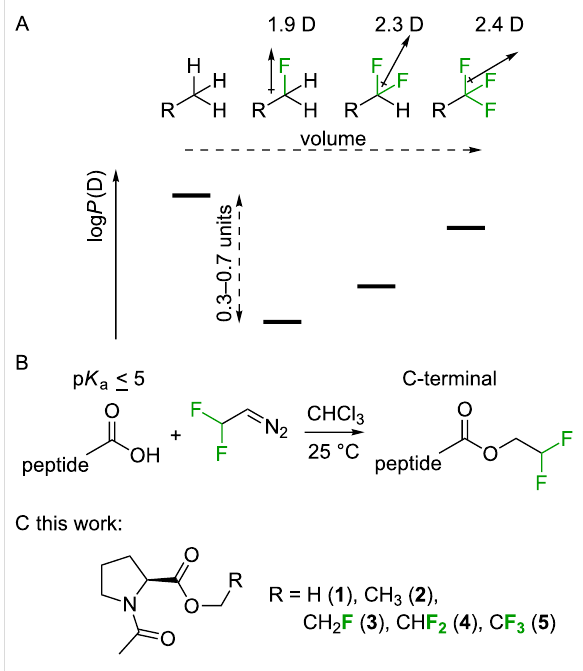
Figure 1: A. Dependence of the lipophilicity (log P ) on the number of fluorine atoms in a partially fluorinated terminal alkyl group demon- strates a characteristic checkmark-shape [41]. B. Selective labeling of carboxylic acids (C-terminus in peptides) with 2,2-difluorodiazoethane yields 2,2-difluoroethyl esters [46]. C. Esters of N -acetylproline studied